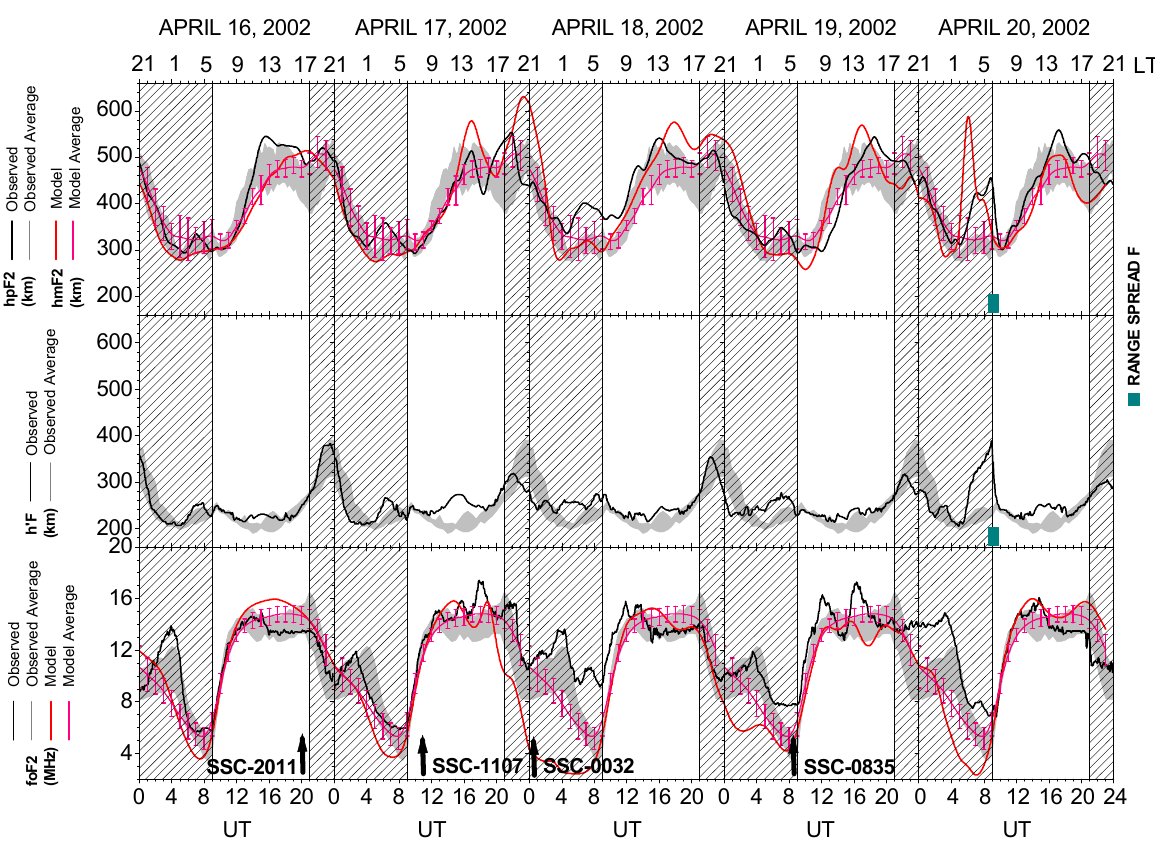
Fig. 3. The variations of h 0 F (black), f oF 2 (black) and hpF 2 (black) during the period 16–20 April 2002 observed at Palmas (PAL). The average quiet-day variations of h 0 F , hpF 2 and f oF 2 are shown as gray bands with the band widths indicating ± 1 standard deviation. The hmF 2 (orange) and f oF 2 (orange) variations obtained from the ASPEN-TIMEGCM model runs are also shown. The average quiet-day variations of hmF 2 and f oF 2 from the ASPEN-TIMEGCM model are shown in red color with error bars ( ± 1 standard deviation). The hatched portions indicate local nighttime periods (18:00–06:00